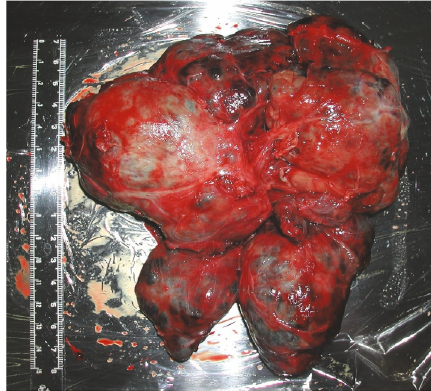
Figure 6: The extirpated tumour (515g, 15 cm × 13